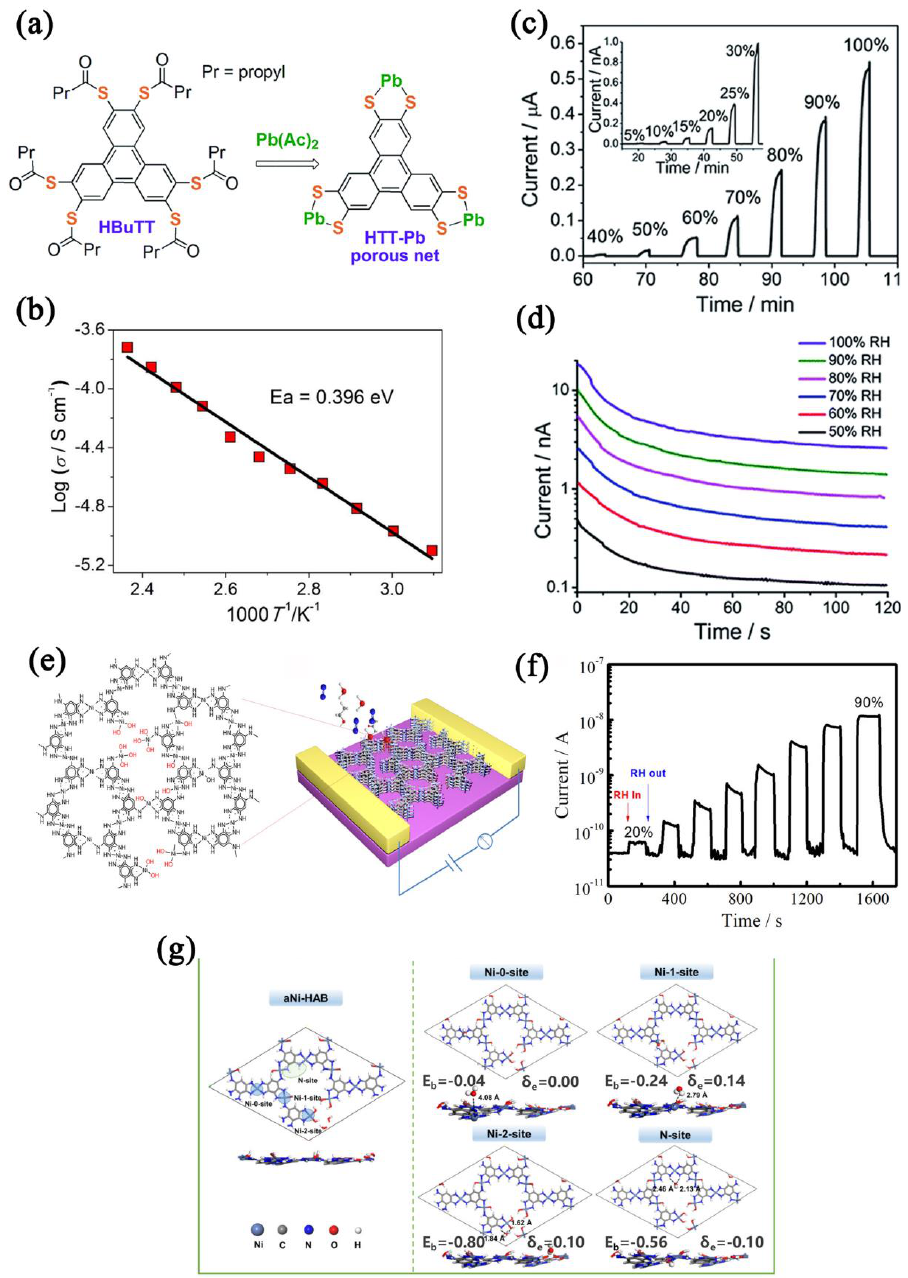
Figure 12. ( a ) Scheme of the synthesis of HTT − Pb framework. ( b ) Calculation of the activation energy of HTT − Pb. ( c ) Response curve of HTT − Pb − based sensor to humidity in the range of 5 – 100% RH. ( d ) Curves of current vs. time of the HTT − Pb − based sensor at various RH obtained by the DC reverse polarity method. Reproduced with permission from Ref. [109]. Copyright 2017, The Royal Society of Chemistry. ( e ) Crystal structure of the missing − linker amorphous aNi − HAB − and aNi − HAB − based sensor. ( f ) Response curve of aNi − HAB − based sensor to humidity in the range of 0 – 90% RH. ( g ) Side and top views of a slab model of aNi − HAB with possible H 2 O adsorption sites: purple, gray, blue, red, and white balls correspond to Ni, C, N, O, and H atoms, respectively. Re- produced with permission from Ref. [111]. Copyright 2021, American Chemical Society.